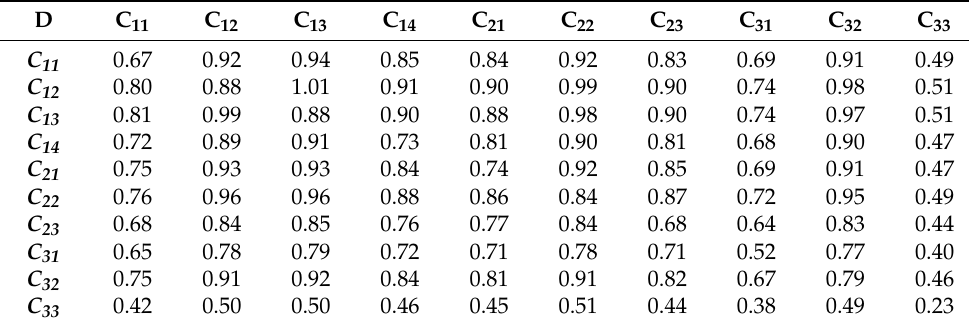
Table 4. Total influence matrix of criteria T C .